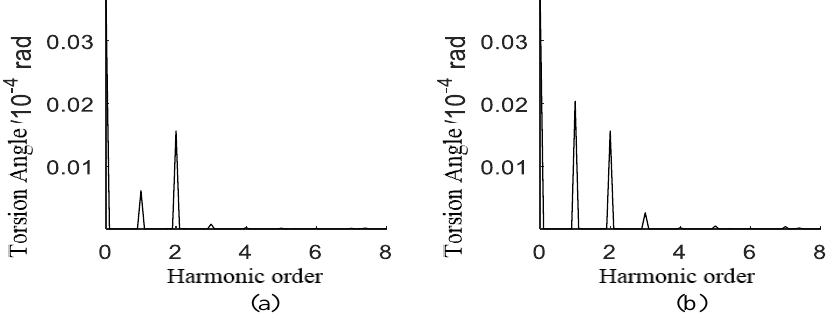
Figure 14. Radial vibration spectrum of generator rotor: ( a ) misalignment 1.5 mm, short-circuit 5%; ( b ) misalignment 5 mm, short-circuit 5%.